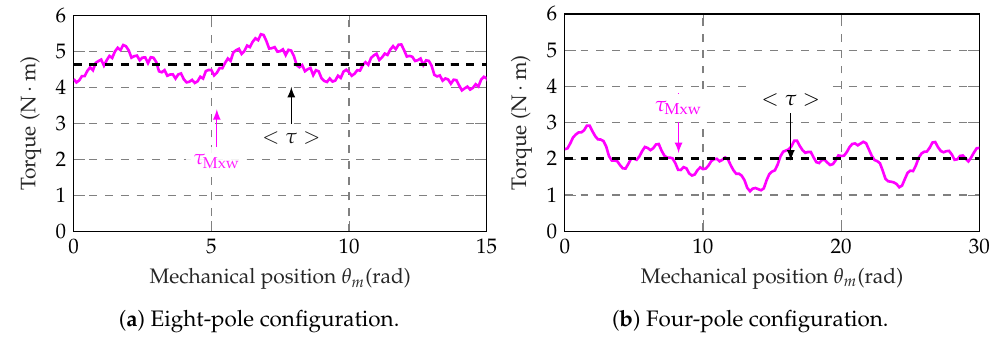
( a ) Eight-pole configuration. (b) 4-pole configuration. Figure 15. Torque ripple in MTPA Figure 15. Torque ripple in MTPA conditions. Figure 15. Torque ripple in MTPA conditions.